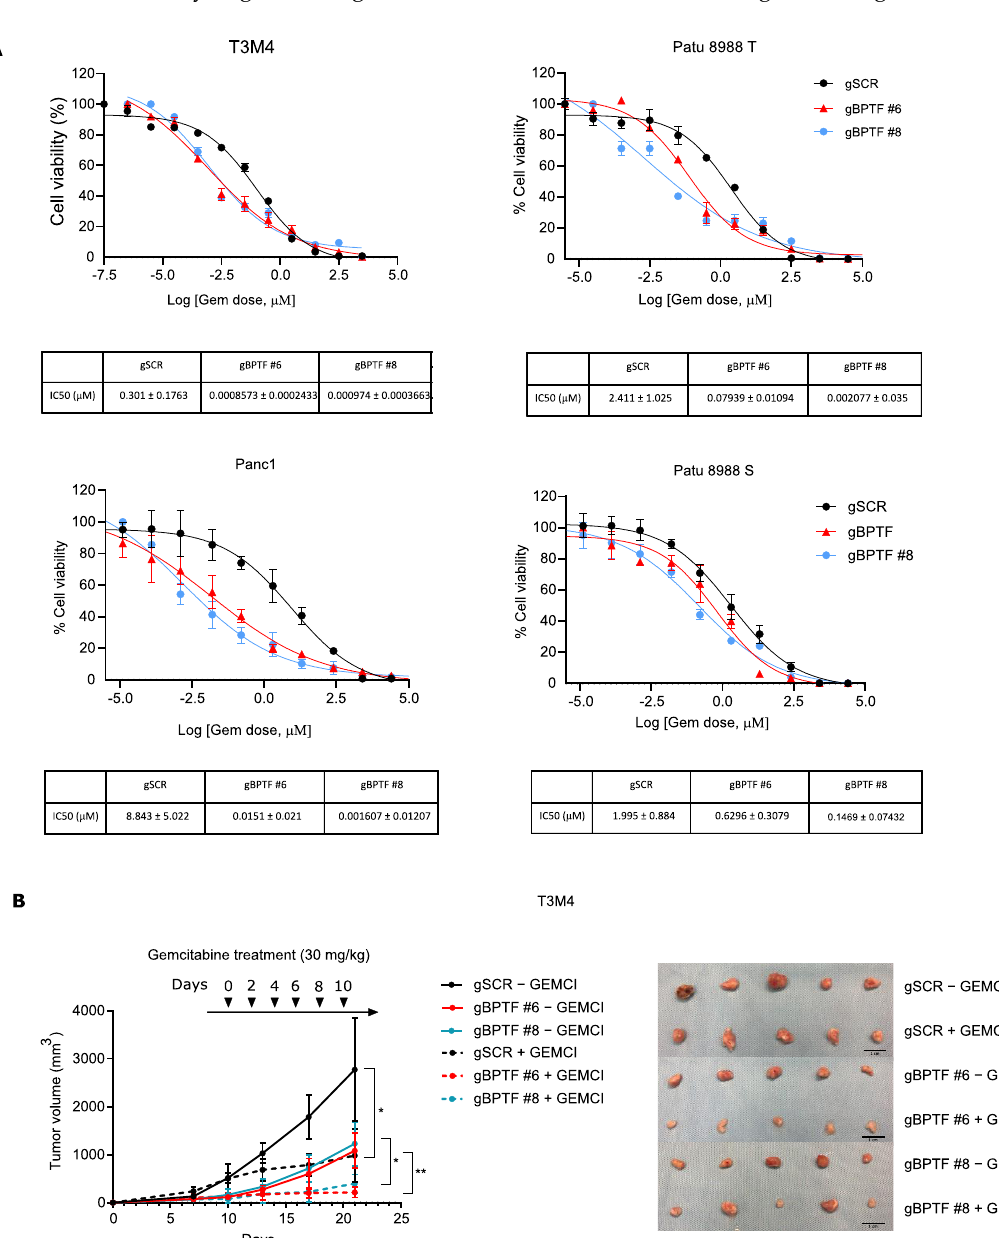
Figure 4 . BPTF-silencing by CRISPRi sensitizes to gemcitabine. ( A ) IC50 analysis and values using ATP-lite in a panel of four PDA human cell lines either BPTF-interfered (gBPTF #6 and gBPTF #8) or non-targeted (gSCR); n = 3. ( B ) Tumour volumes of nude mice subcutaneously implanted with T3M4 cell lines either BPTF-interfered (gBPTF #6 and gBPTF #8) or non-targeted (gSCR); gemcita- bine administration was done when tumour volume reached 200 mm 3 at a dose of 30 mg/kg or PBS every two days; n = 8; and representative images of the different tumours. Significance was consid- ered for * p < 0.05, ** p < 0.01.